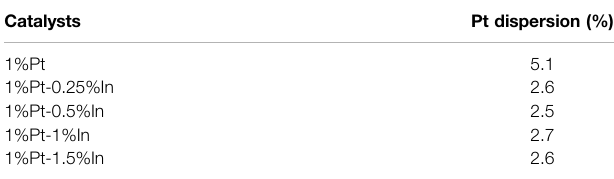
TABLE 1 | CO chemisorption results. Table shows the Pt dispersion calculated using a CO:Pt stoichiometry 2:1.